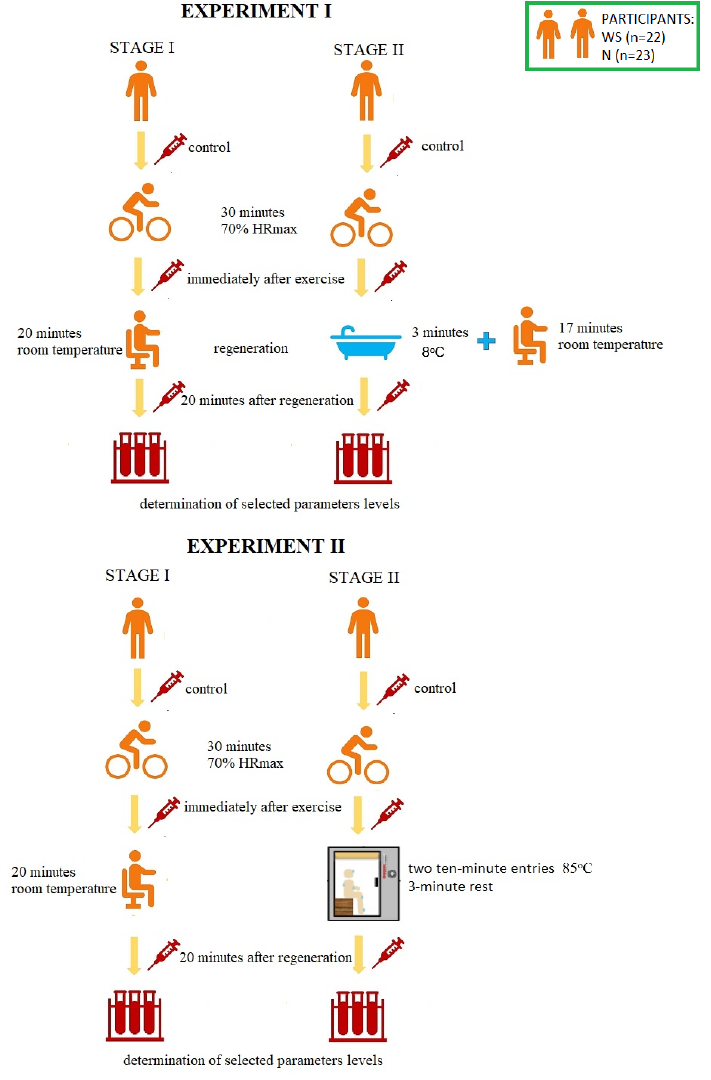
Figure 1. The scheme of the course of the research. HRmax—maximum heart rate, WS—winter swimmers, N—novices.